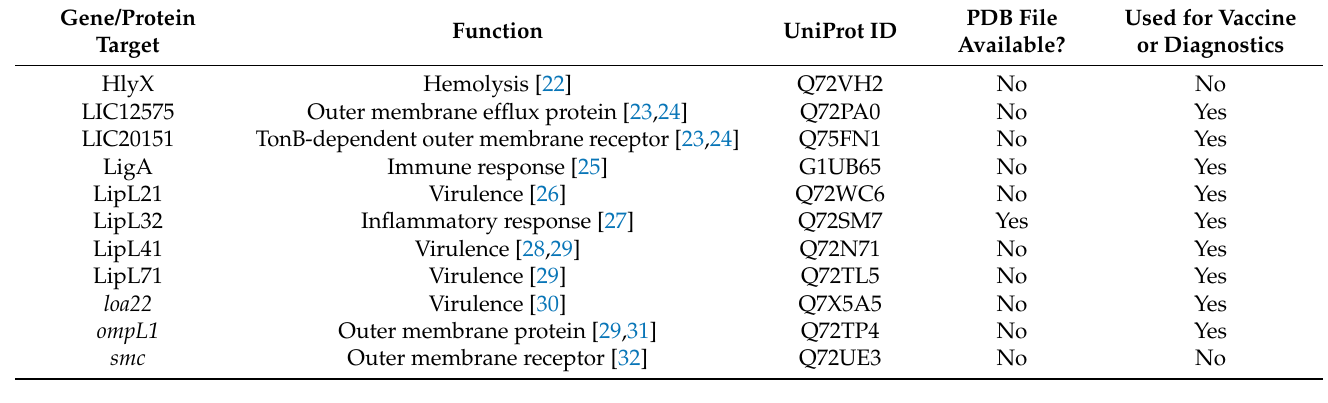
Table 1. Selected Leptospira outer membrane proteins used in this study.